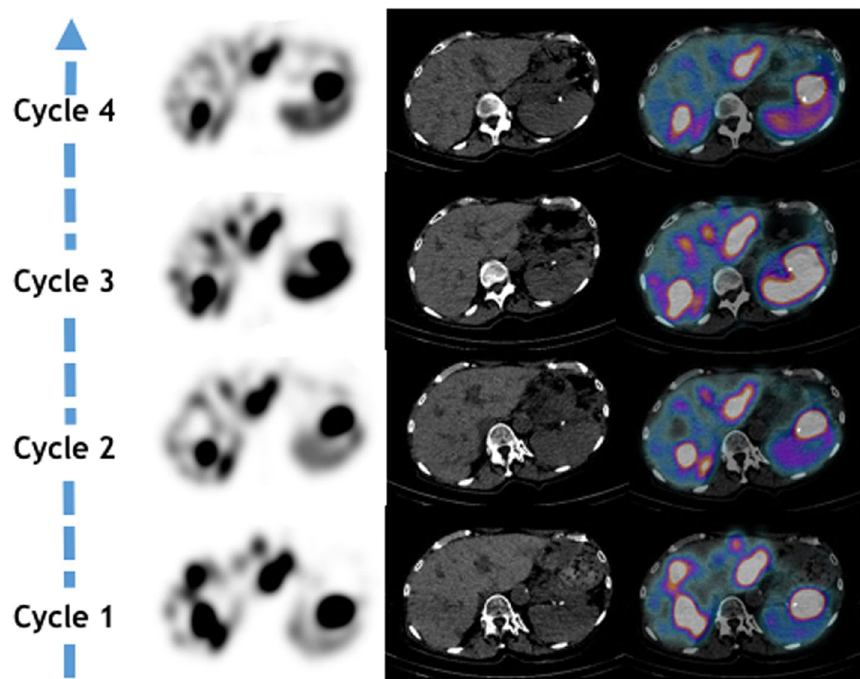
Fig. 3 Axial slices of SPECT, CT and fused SPECT/CT images showing uptake in the primary pancreatic tumor and liver metastases after each cycle of